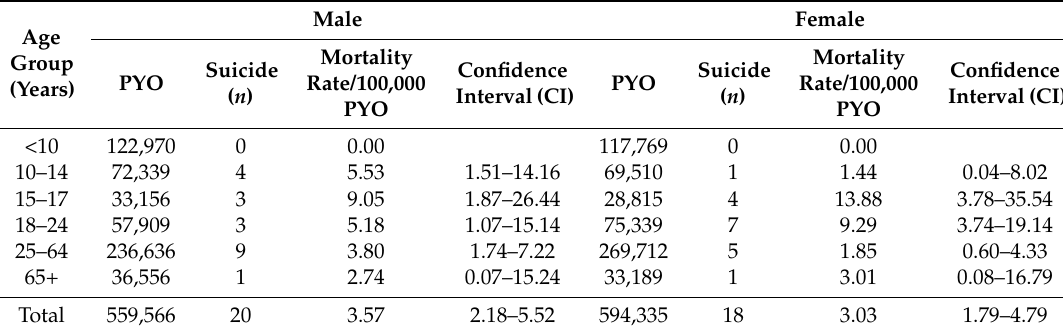
Table 3. Suicide rates by age and sex, rural Bangladesh.